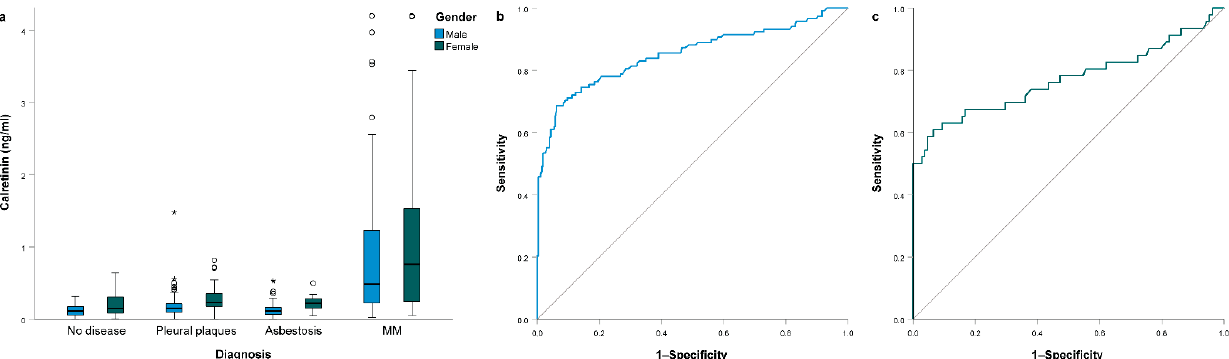
Figure 2. ( a ) Serum calretinin concentration in different subject groups stratified by gender; ( b ) ROC curve analysis for serum calretinin concentration comparing malignant mesothelioma (MM) patients with all other subjects among men; ( c ) ROC curve analysis for serum calretinin concentration comparing MM patients with all other subjects among women. All boxplots represent median with interquartile range, while outliers are represented using circles and extreme outliers are represented using * symbol.